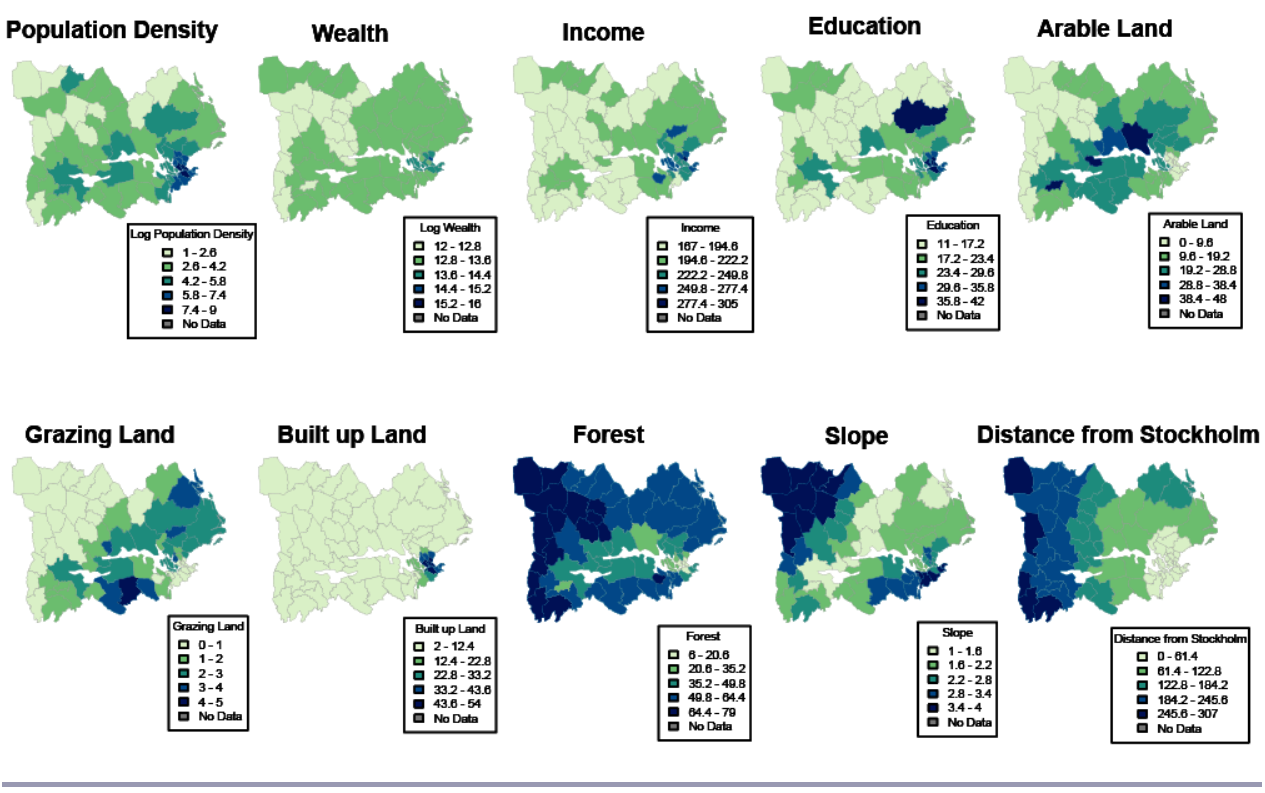
Fig. 2 . Distribution of drivers across the Norrström drainage basin’s municipalities. The values of drivers are shown in equal interval quintiles. Darker shades of blue represent higher values for the drivers. Levels of the drivers are shown in the legends for each